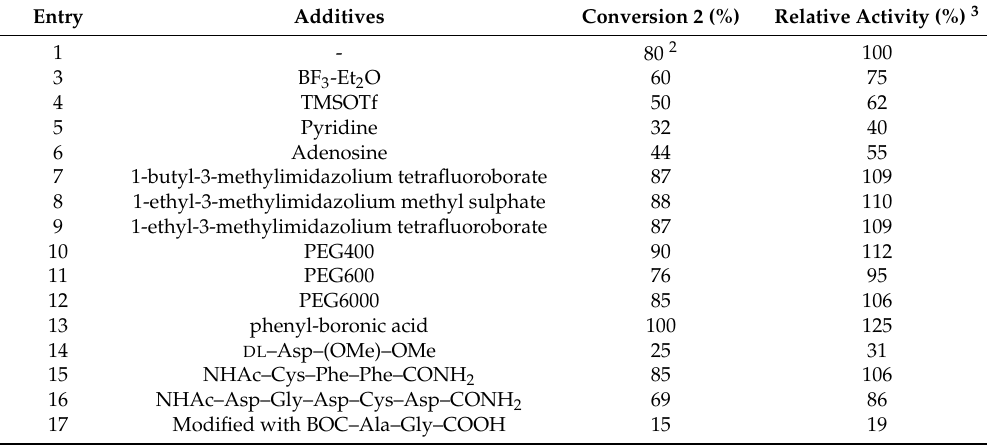
Table 1. Additive screening for ring-closing metathesis of 1 catalyzed by soluble Hoveyda–Grubbs second-generation catalyst 1